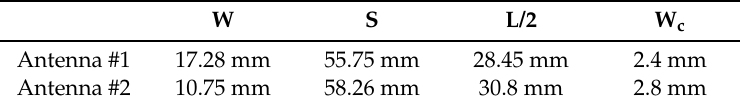
Table 1. Dimension of Bow-Tie Antennas.